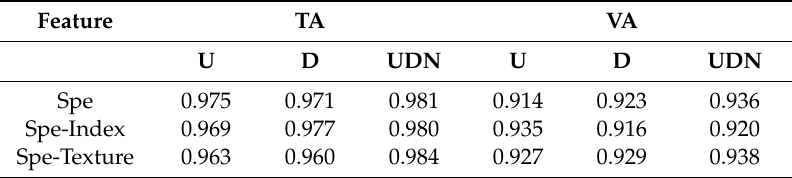
Table 3. The overall training and validation accuracies of the improved U-net (U), improved DenseNet (D), and U-net-DenseNet-coupled network (UDN) algorithms based on the three feature groups of Spe, Spe-Index, and Spe-Texture. The algorithms in this table did not include object-based U-net-DenseNet-coupled network (OUDN), since the OUDN algorithm was based on UDN algorithm to optimize classification results.